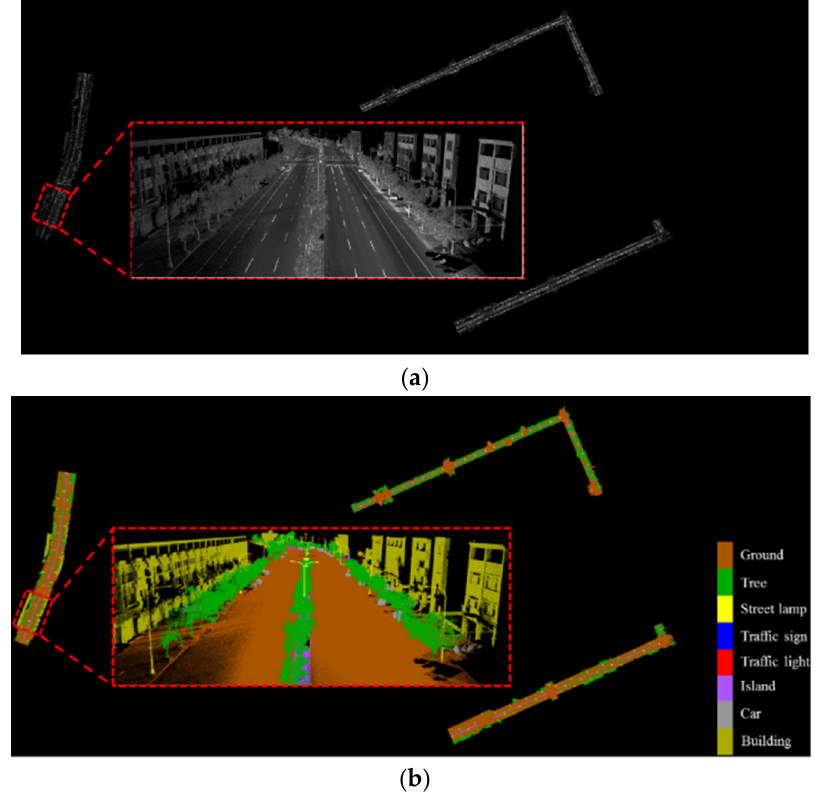
Figure 3. Test area for the MLS point cloud dataset: ( a ) Point cloud data (displayed by intensity); ( b ) Labelled categories.